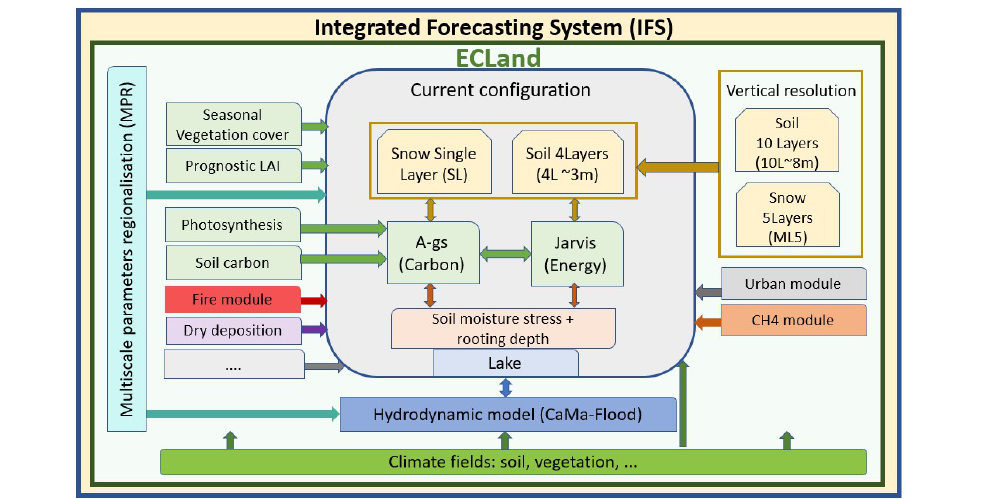
Figure 1. Simplified representation of the main ECLand system components and its prospective evolution (inner light green box) as part of the full Integrated Forecasting System (outer yellow box) where the current ECLand main components are within the light grey